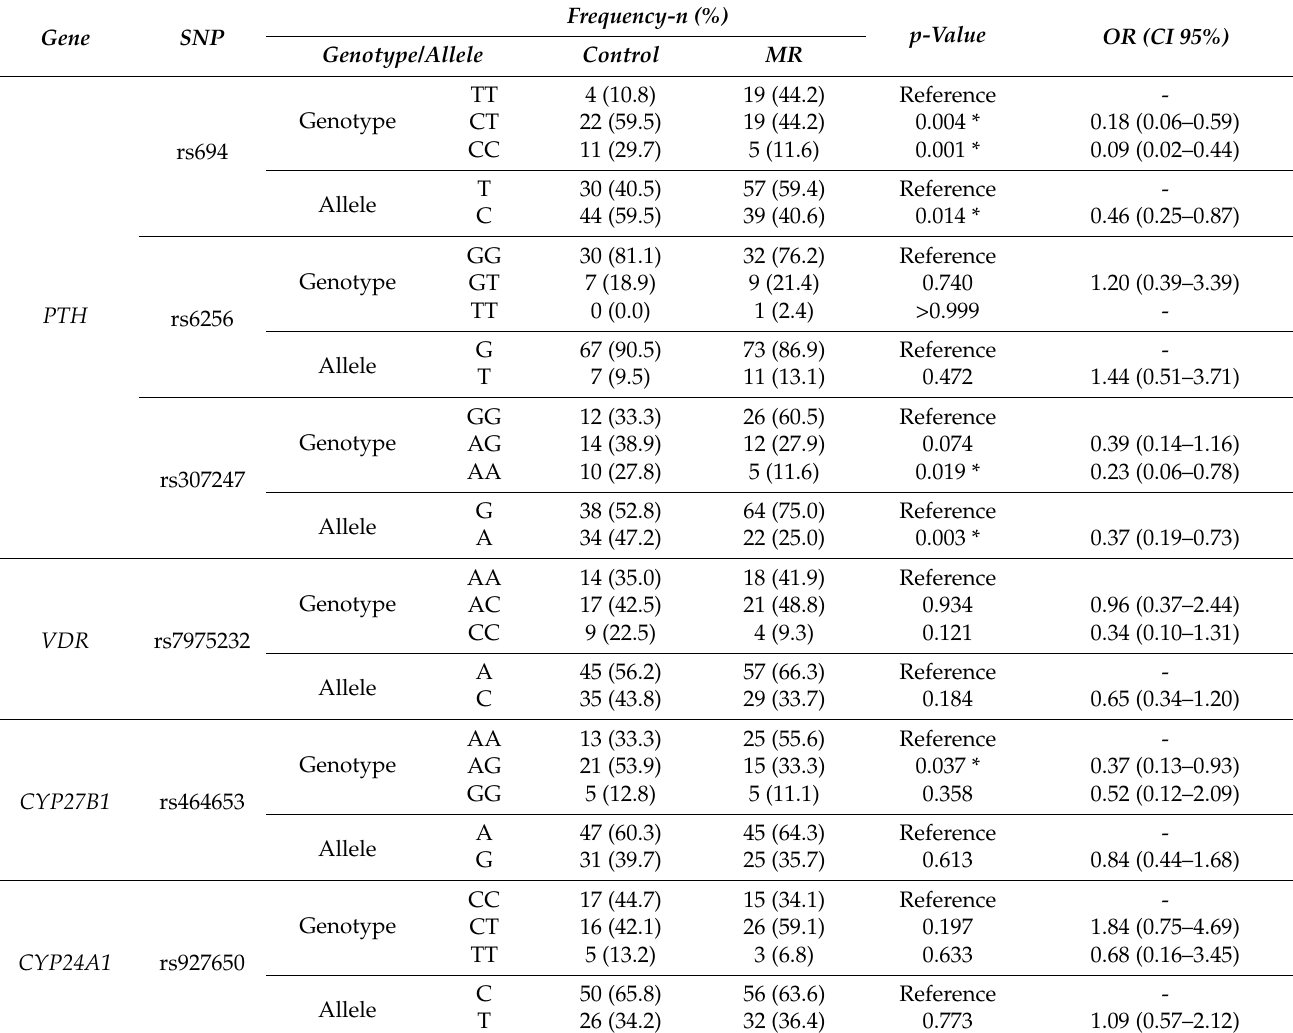
Table 3. Genotype and allele distribution among the